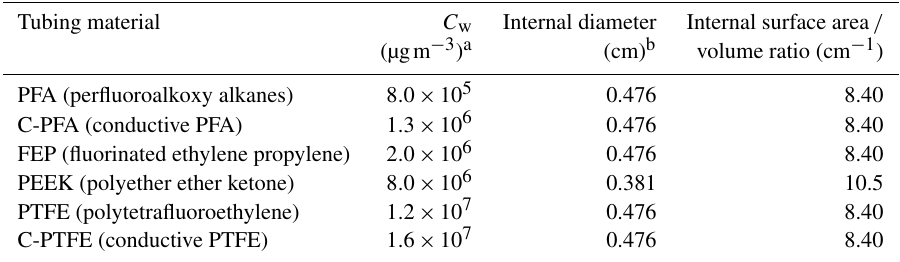
Table 2. Fitted values of C w for absorbent tubing